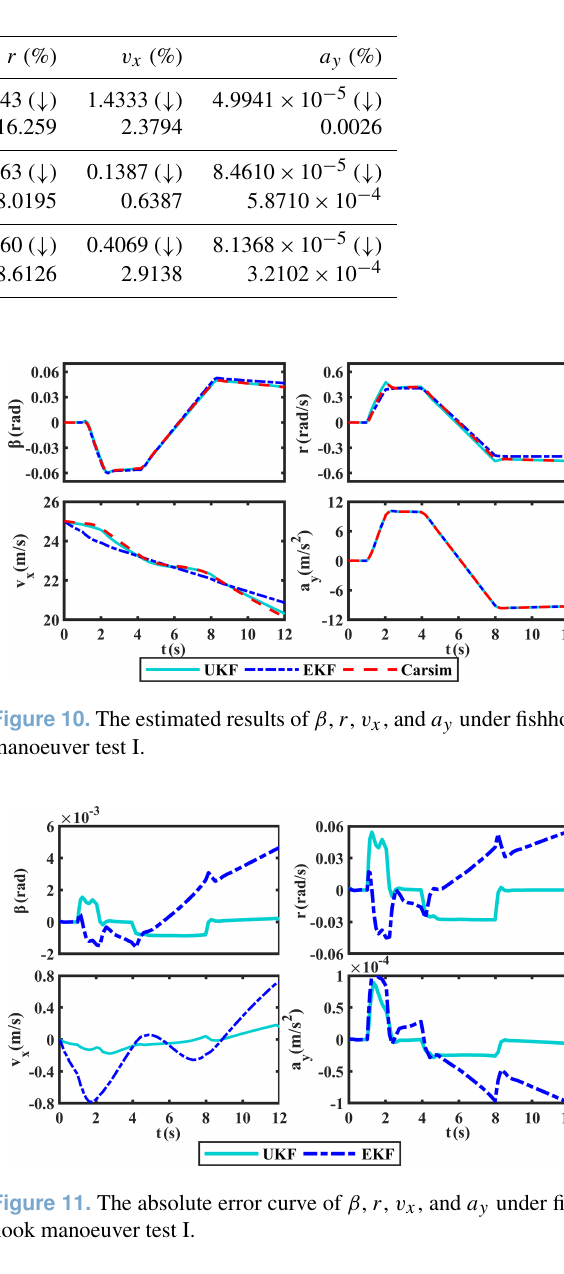
Figure 11. The absolute error curve of β , r , v x , and a y under fish- hook manoeuver test